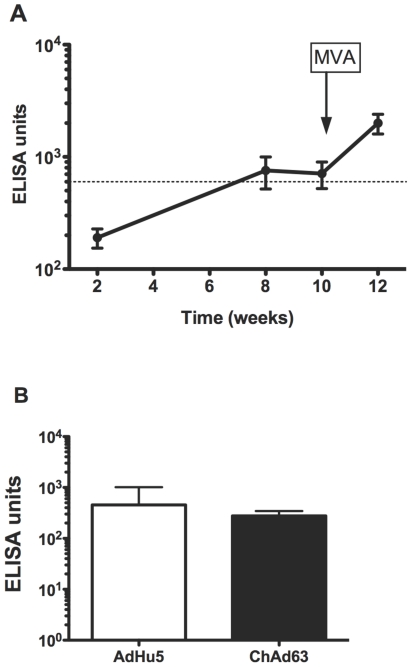
Pfs25 specific total IgG responses following Ad-MVA Pfs25 and ChAd63 Pfs25 immunization.
(A) BALB/c mice were immunized with Ad-MVA Pfs25 (AdHu5 Pfs25 prime, MVA Pfs25 boost). Total IgG responses against recombinant Pfs25 protein were measured by ELISA in the serum of mice taken at the number of weeks following first immunization as shown. Mean ELISA titers ± sem (n = 10) are shown. Titers increased over time following the first immunization and were boosted following MVA Pfs25 administration at week 10 (arrow). The dotted line represents the titer required to provide 50% efficacy against P. falciparum in a SMFA using alternative vaccine platforms, according to previously published methods. (B) BALB/c mice were immunized with ChAd63 Pfs25 (n = 25) or AdHu5 Pfs25 (n = 10). Total IgG responses against recombinant Pfs25 protein were measured by ELISA in the serum of mice taken 8 weeks following a single immunization. Geomean ELISA titers ±95% CI are shown.